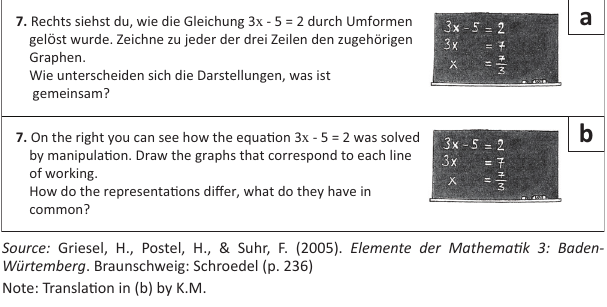
7. Rechts siehst du, wie die Gleichung 3 x - 5 = 2 durch Umformen gel(cid:5)st wurde. Zeichne zu jeder der drei Zeilen den zugehörigen Graphen. Wie unterscheiden sich die Darstellungen, was ist gemeinsam? 7. On the right you can see how the equa‚on 3 x - 5 = 2 was solved by manipula‚on. Draw the graphs that correspond to each line of working. How do the representa‚ons differ, what do they have in common? Source: Griesel, H., Postel, H., & Suhr, F. (2005). Elemente der Mathematik 3: Baden- Würtemberg . Braunschweig: Schroedel (p. 236) Note: Translation in (b) by K.M. FIGURE 10: (a) Task from Elemente der Mathematik 3 linking linear graphs to linear equations, (b) translation of the task.